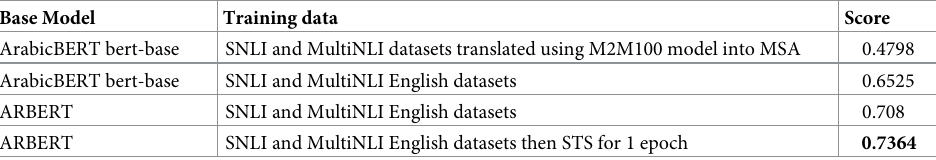
Table 3. Accuracy of machine translation based and interleaved MSA models tested based on Spearman rank cor- relation between the cosine similarity of sentence representations and the reference labels of the testing dataset in